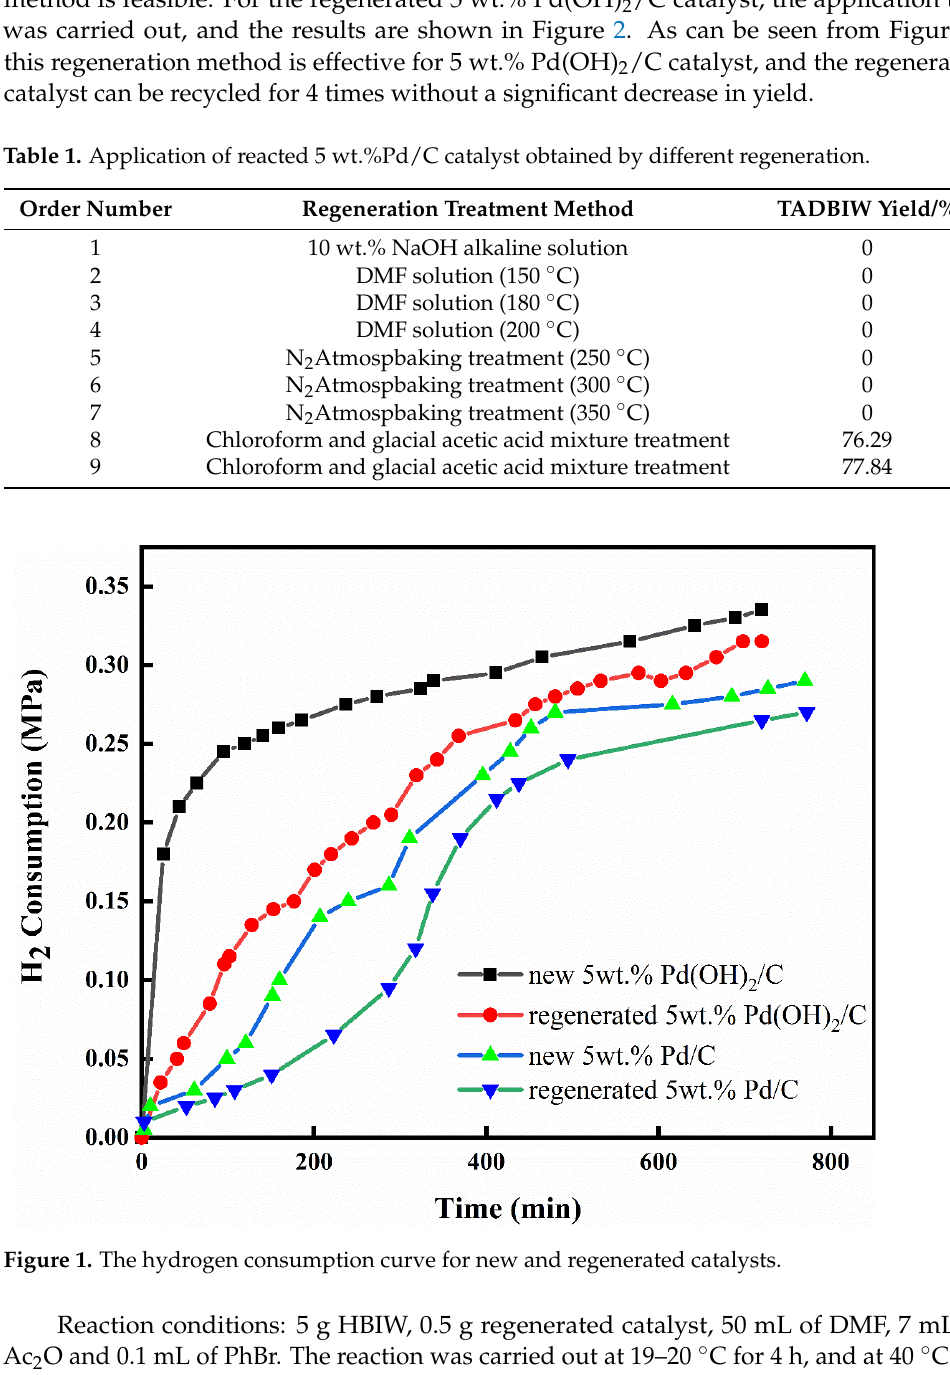
Figure 2. The recycle test results for regenerated 5 wt.% Pd(OH) 2 /C catalyst. Reaction conditions: 5 g HBIW, 0.5 g regenerated catalyst, 50 mL of DMF, 7 mL of Ac 2 O and 0.1 mL of PhBr. The reaction was carried out at 19 – 20 °C for 4 h, and at 40 °C for another 8 h. As the catalytic activity is affected by the amount of catalyst added, the yield of TADBIW against the different amounts of added catalyst was investigated in detail, and the results are shown in Table 2. It can be seen that the reaction rate can be accelerated by adding more catalyst in a certain range when the substrate is constant. However, ex- cessive use of catalysts can greatly increase the cost. When the content of the catalyst is 10% of HBIW, the achieved yield of TADBIW was 79.71% and with the highest H 2 con- sumption of 0.300 MPa. Table 2. Effect of 5 wt.% Pd/C catalyst dosage on TADBIW yield. Catalyst Amount (x wt% of HBIW)